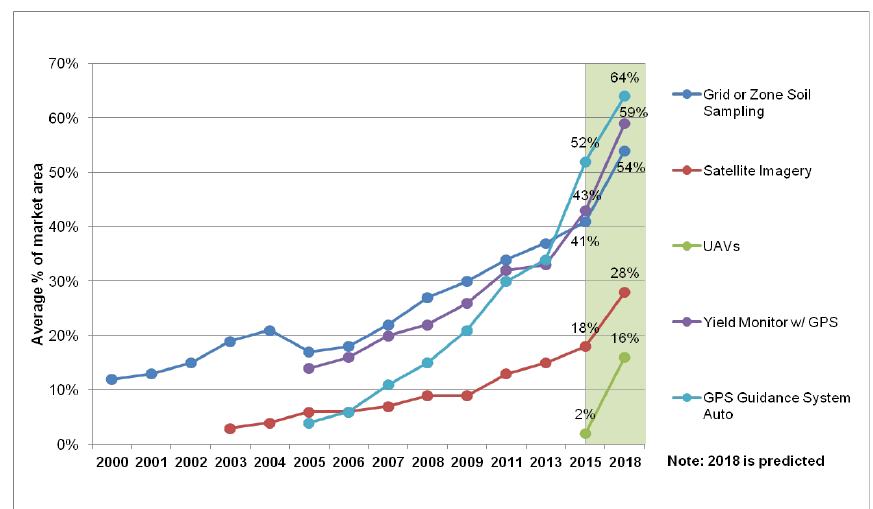
Fig. 3. Estimated market area using precision services over time (adapted from Erickson and Widmar,